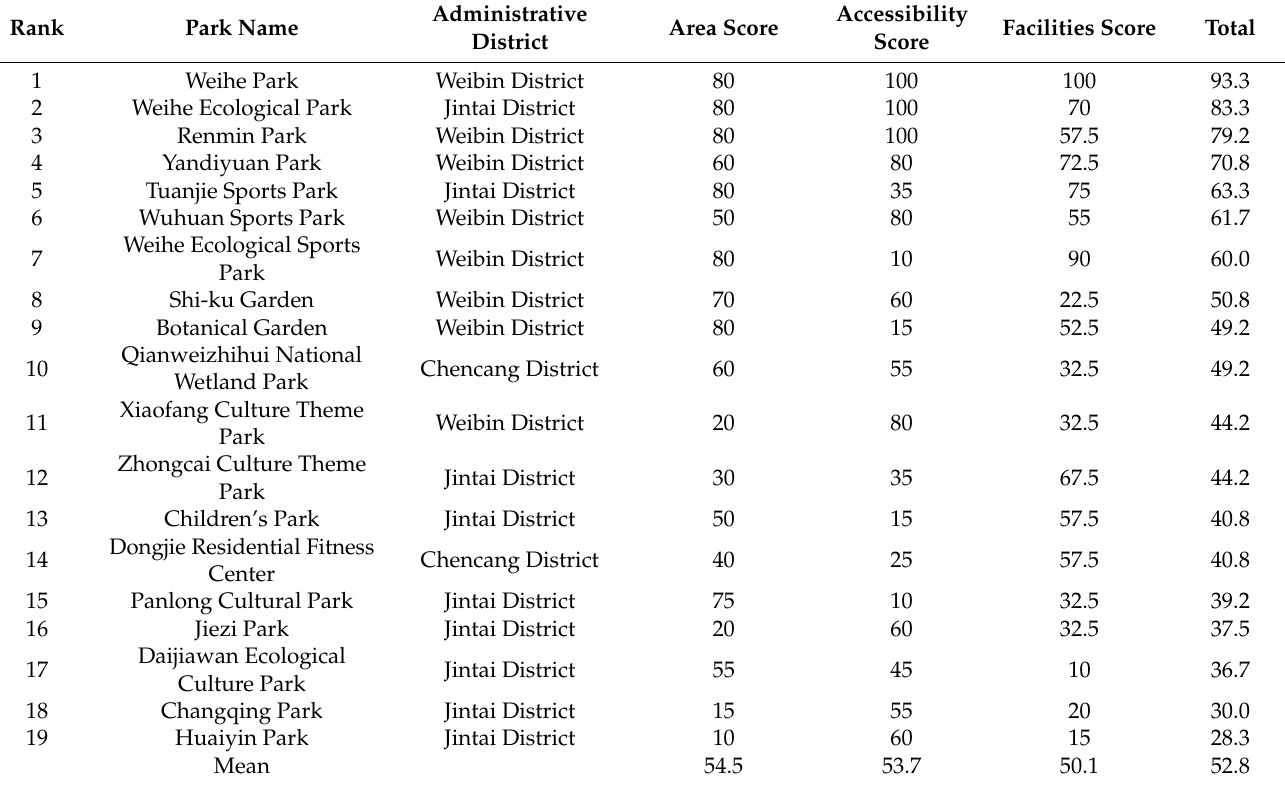
Table 3. Baoji urban park scores and